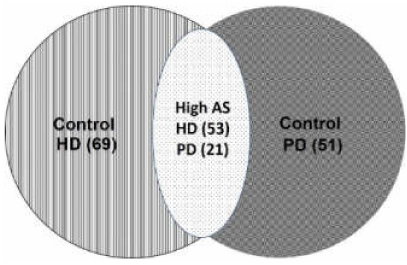
Figure 1. Venn diagram of dialysis patients. Table 1. Clinical variables of the dialysis patients in high AS or control groups.